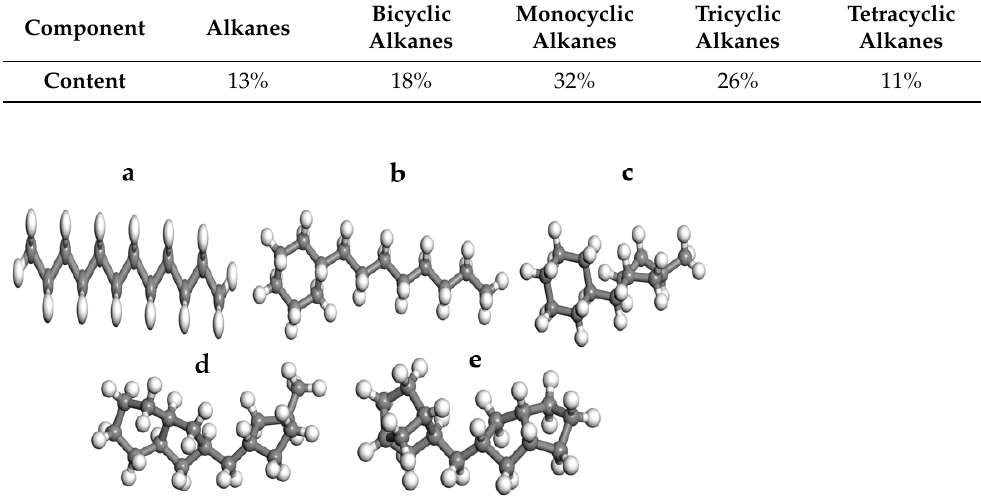
Figure 1. Molecular model of naphthenic mineral oil: ( a ) Alkanes C 12 H 26 ; ( b ) Monocyclic alkanes C 14 H 28 ; ( c ) Bicyclic alkanes C 13 H 24 ; ( d ) Tricyclic alkanes C 16 H 28 ; ( e ) Tetracyclic alkanes C 16 H 26 .